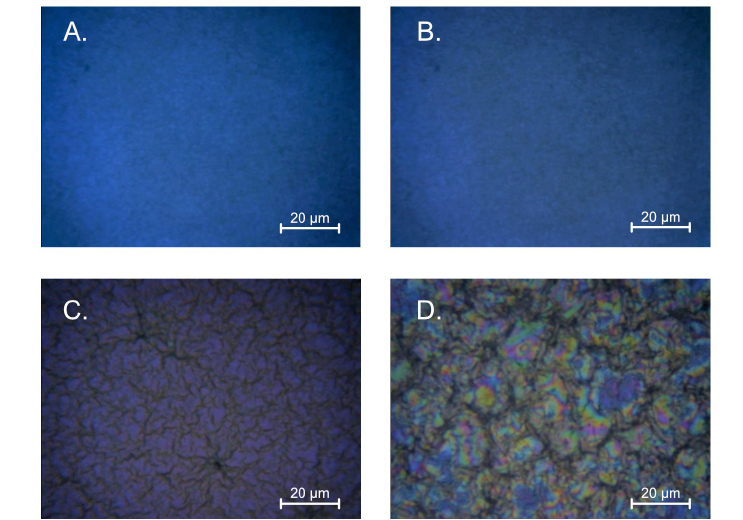
Figure 2. Summary of the morphology for the layers produced on silicon ( A ) using a solution with 5% concentration of DEA; ( B ) using a solution with 10% concentration of DEA; ( C ) using a solution with 5% concentration of MEA; ( D ) using a solution with 10% concentration of MEA.